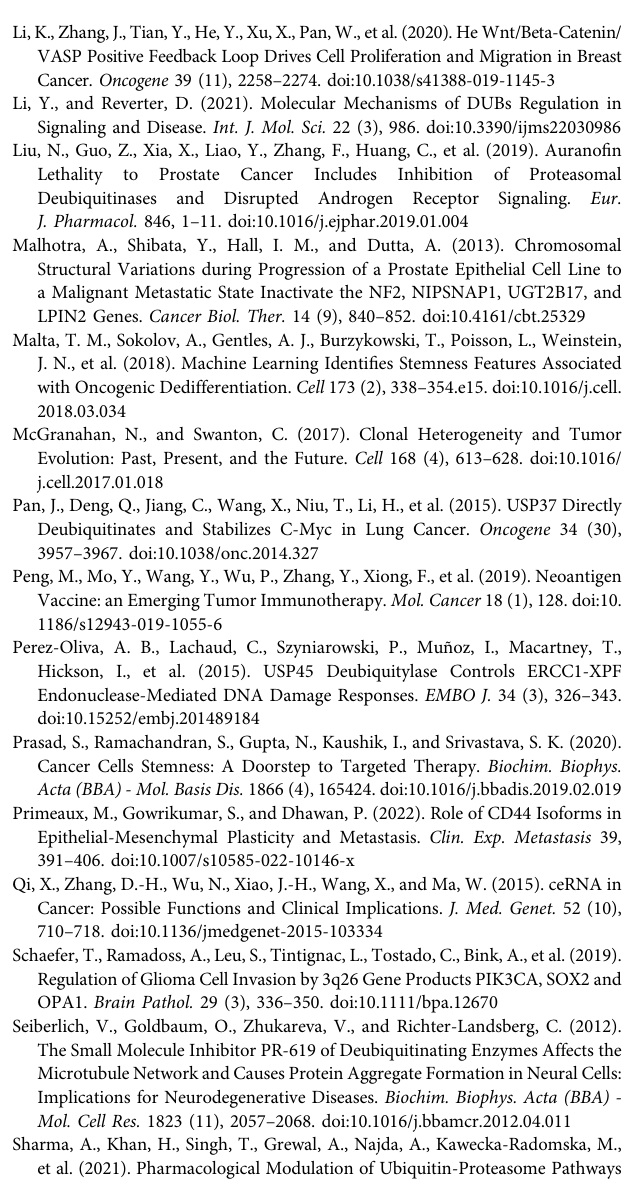
AL137003.2wereanalyzed.InLGG (H) ,thecorrelationamongUSP45,miR-328-3p with HELLPAR was analyzed. Supplementary Figure S3 | The construction of downstream regulatory network for USP45 in CHOL, NSCLC, MESO, SKCM. Supplementary Figure S4 | The construction of downstream regulatory network for USP45 in SARC, ESCA, UVM, ACC. Supplementary Figure S5 | The construction of downstream regulatory network for USP45 in LIHC, PRAD, RCC, HNSC, STAD. Supplementary Figure S6 | The construction of downstream regulatory network for USP45 in PAAD, UCS, UCEC, CESC, PCPG. Supplementary Figure S7 | The construction of downstream regulatory network for USP45 in BLCA, THCA, COADREAD, BRCA, GBMLGG. Supplementary Figure S8 | The correlation between the drugs sensitivity and USP45 in